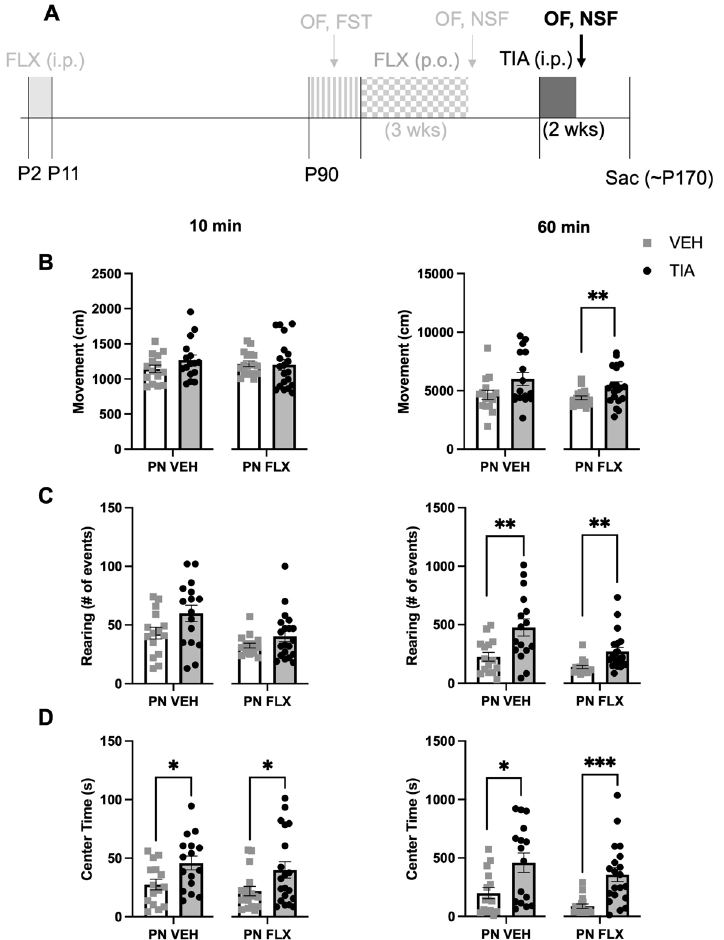
Figure 4. Decreased anxiety-like behavior in the first 10 and full 60 min of open field following adult tianeptine treatment in PNVEH and PNFLX exposed C57 mice. ( A ) Timeline of experiment: The window for developmental administration of fluoxetine as well as prior phases of the experiment are in faded light grey; Black and dark grey indicate tianeptine administration in adulthood and follow up NSF and OF tests. ( B ) Ambulatory movements in the first 10 min of open field (left panel; PNVEH: unpaired t-test, p = 0.1643; PNFLX: unpaired t-test, p = 0.8569). Same for total 60 min (right panel; PNVEH: unpaired t-test, p = 0.0594; PNFLX: unpaired t-test, ** p = 0.0096) ( C ) Rearing movements in the first 10 min (left panel, PNVEH: unpaired t-test, p = 0.0631; PNFLX: unpaired t-test, p = 0.1405). For total 60 min (right panel; PNVEH: unpaired t-test, ** p = 0.0053; PNFLX: unpaired t-test, ** p = 0.0057) ( D ) Time spent in center in the first 10 min (left panel, PNVEH: unpaired t-test, * p = 0.0198; PNFLX: unpaired t-test, * p = 0.0386). For total 60 min (right panel, PNVEH: unpaired t-test, * p = 0.0120; PNFLX: unpaired t-test, *** p = 0.0002). Light gray squares represent adult vehicle-treated animals. Black circles and grey bars represent adult tianeptine-treated animals. N = 15 PNVEH- VEH, 16 PNVEH-TIA, 17 PNFLX-VEH, 20 PNFLX-TIA. Bars represent mean. Error bars represent standard error. * p < 0.05, ** p < 0.01, *** p < 0.001, **** p <